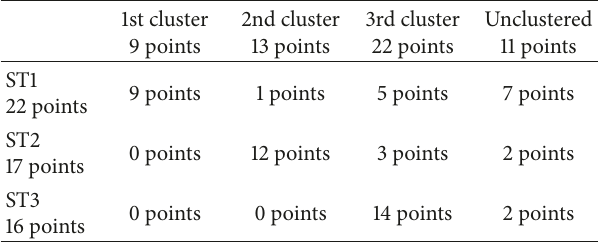
Table 2: Correspondence between the original classes and the clusters constructed by the proposed algorithm (with outliers).